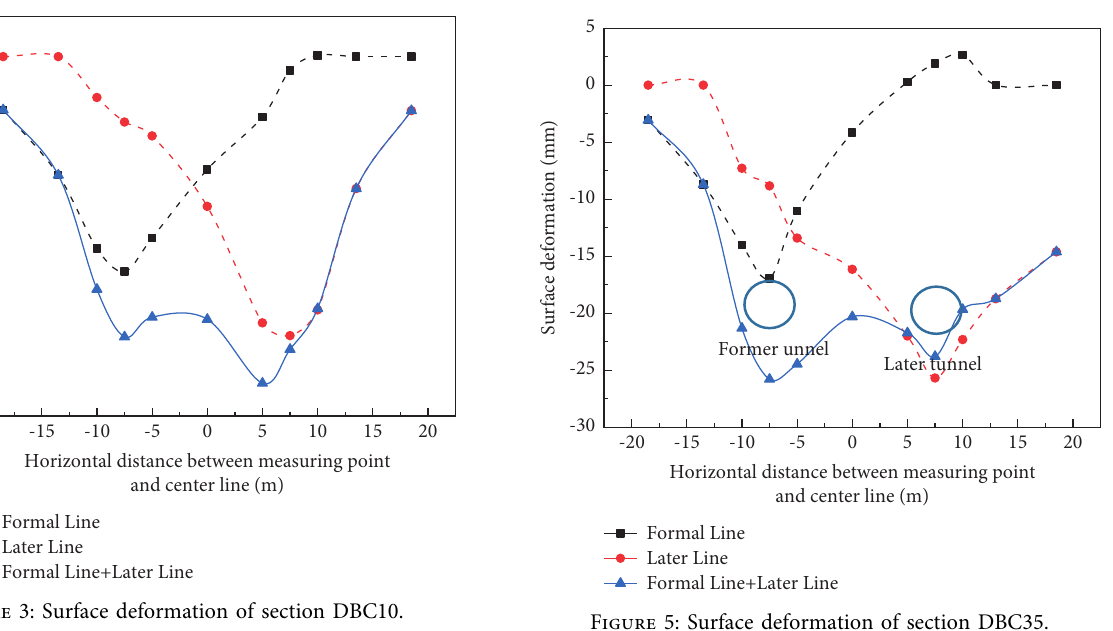
Figure 5: Surface deformation of section DBC35.